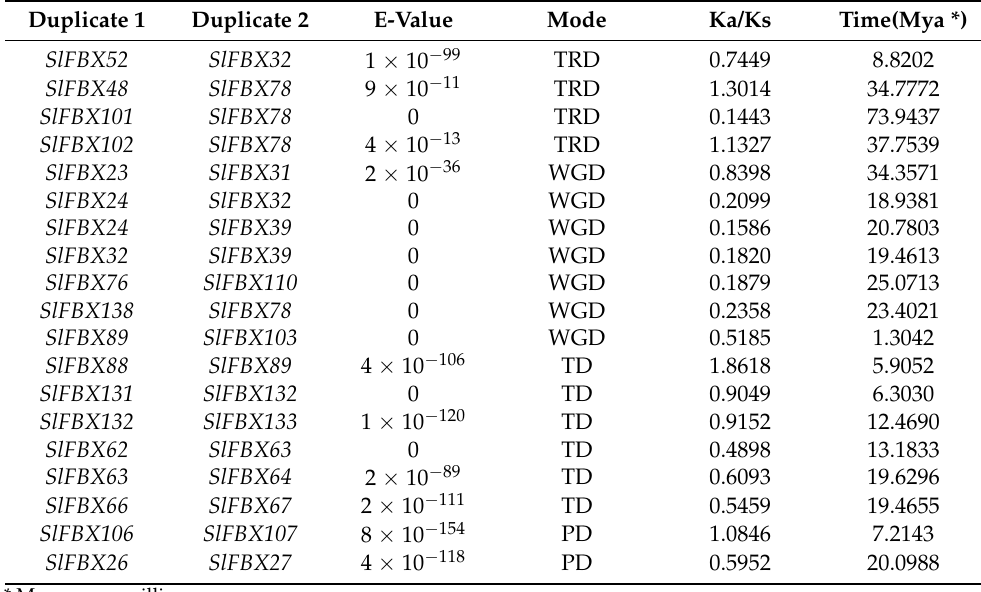
Table 1. The duplication pairs genes of SlFBX gene family in tomato.